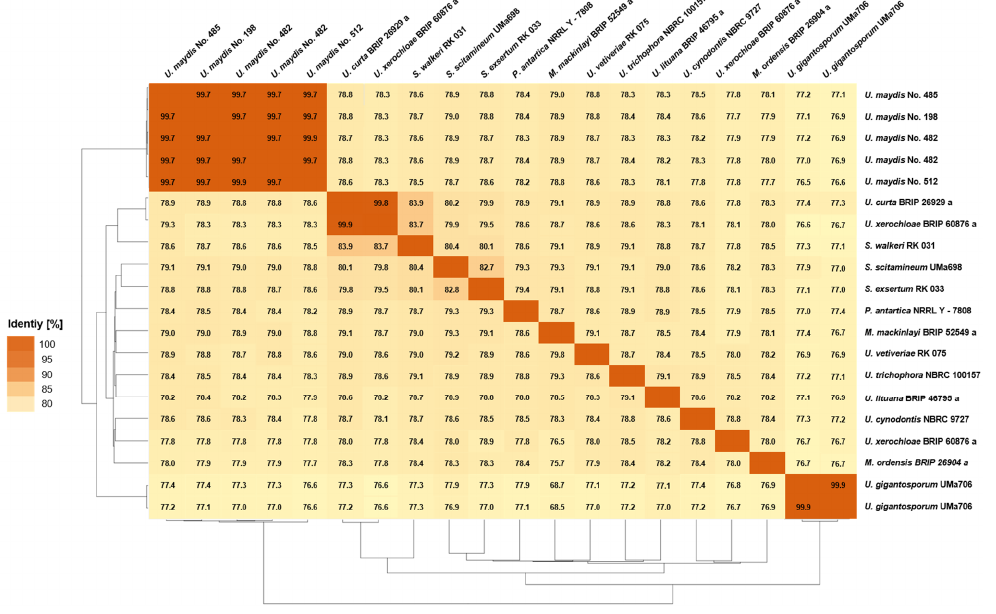
Figure 3. Pairwise Average Nucleotide Identity (ANI) analysis between genome-sequenced Ustilaginaceae. The ANI between the query genome and the reference genome was calculated as the mean identity of all BLASTN matches [42]. Two isolates were sequenced in the case of U. maydis No. 482 and U. gigantosporum Uma706.